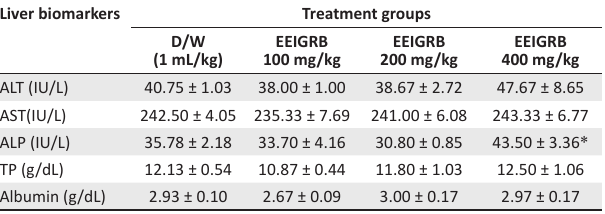
n = 6. Note: Values are expressed as mean ± standard error of mean.